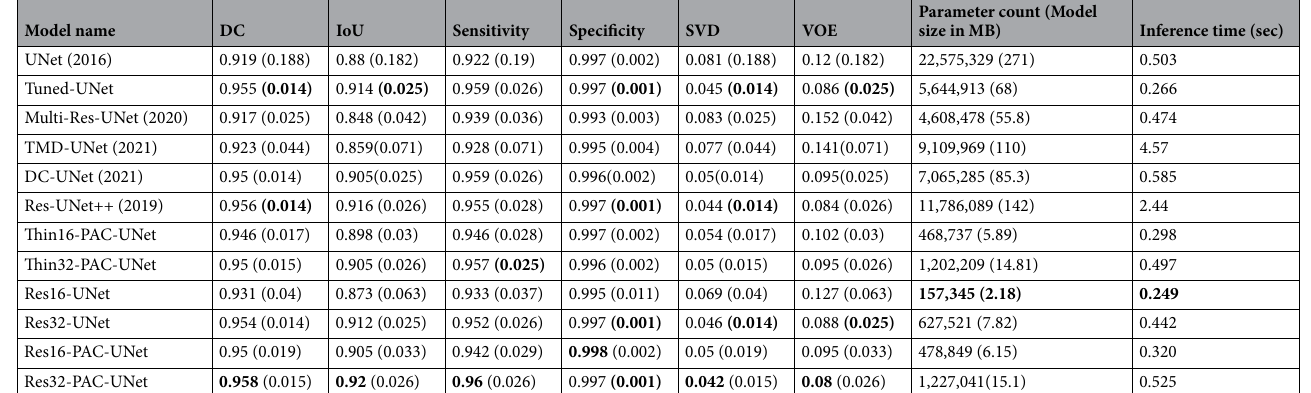
Table 2. Segmentation performance, disk utilization, and inference time of the proposed models with/without PAC module and related work, trained using modified surface loss. Significant values are in